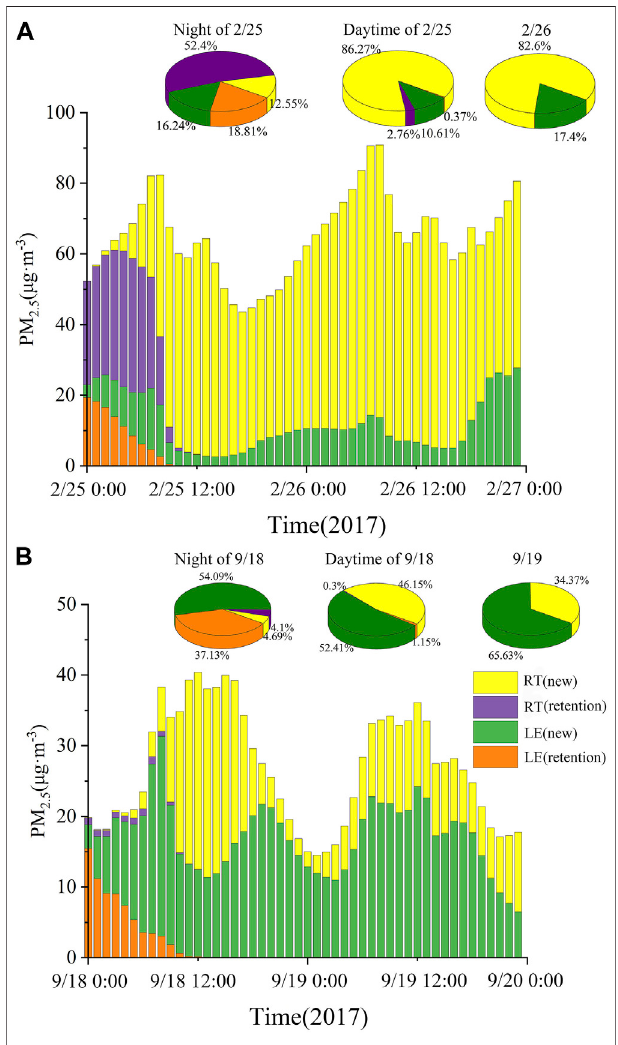
FIGURE 9 | The simulated PM 2.5 and pie chart of retention PM 2.5 and newPM 2.5 inShanghaiinFebruary (A) andSeptember (B) 2017(RT:Regional Transport, LE: Local